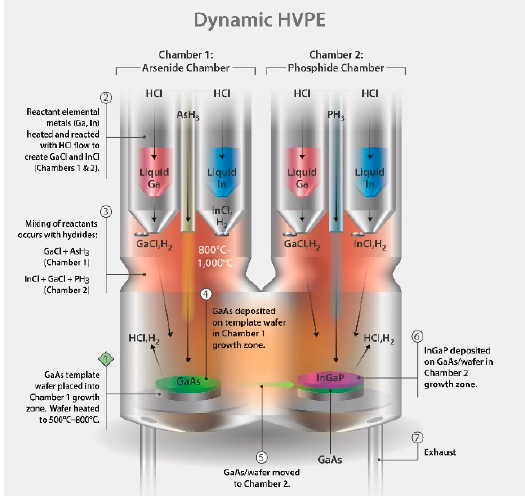
Figure 1. Schematic of the two-chamber dynamic hydride vapor phase epitaxy (D-HVPE) reactor at NREL, showing the side-by-side steady-state reactions for GaAs and GaInP. The substrate is rapidly shuttled between the growth chambers to create high-quality, chemically-abrupt interfaces.